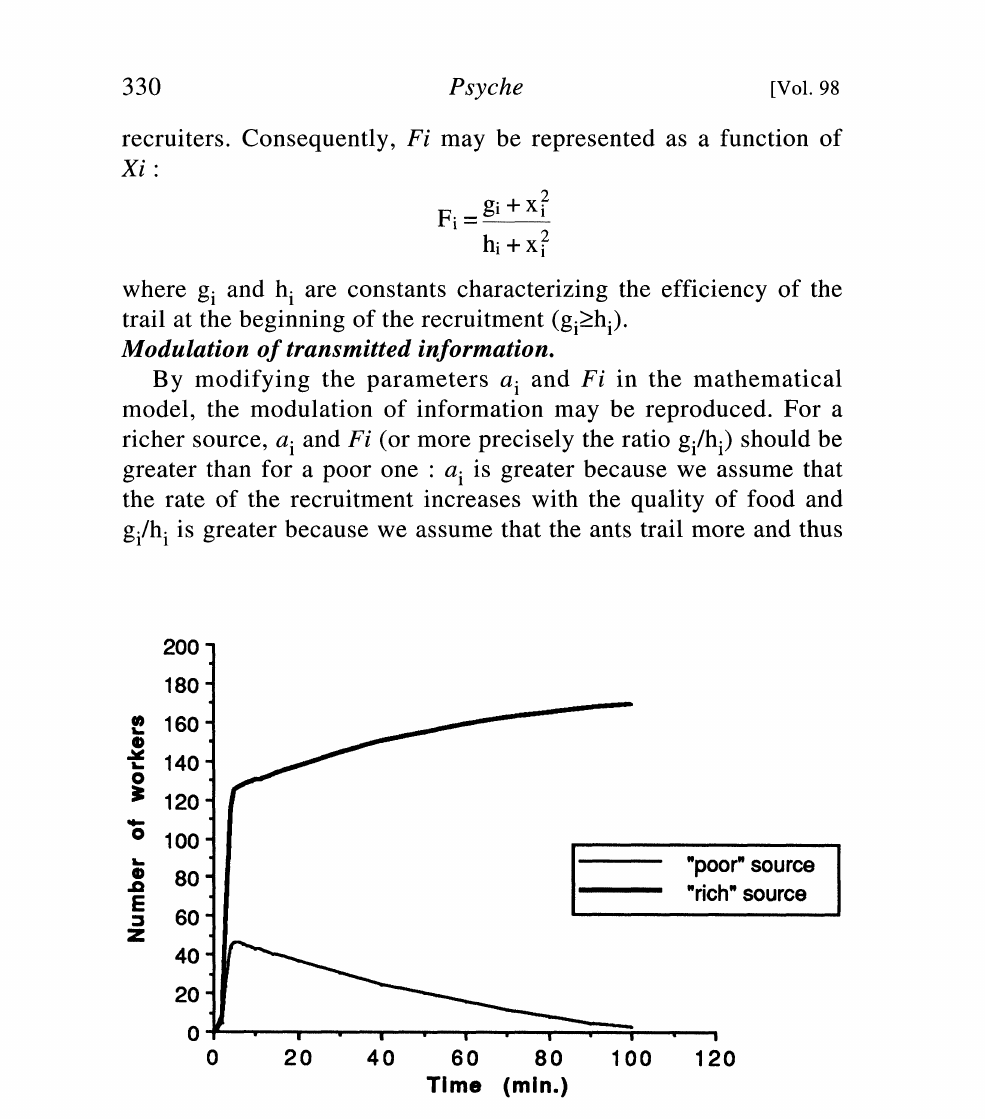
Figure 3. Theoretical simulations changes over time of the worker population at two sucrose sources introduced